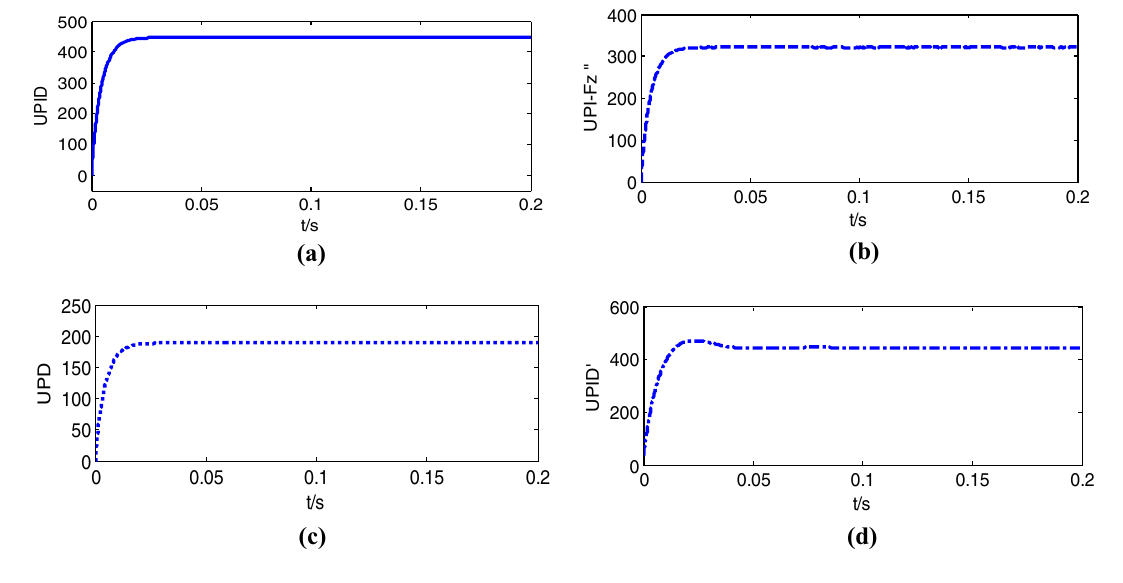
Fig. 7 The control signals of the system: a U PID , b U PI − Fz �� , c U PD , d U PID ′